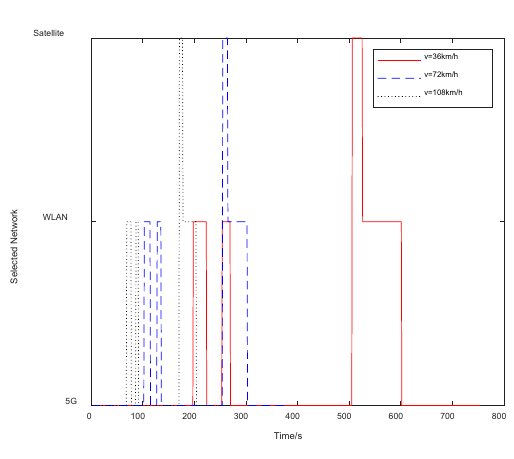
Fig. 7. Handover decisions at different speeds.